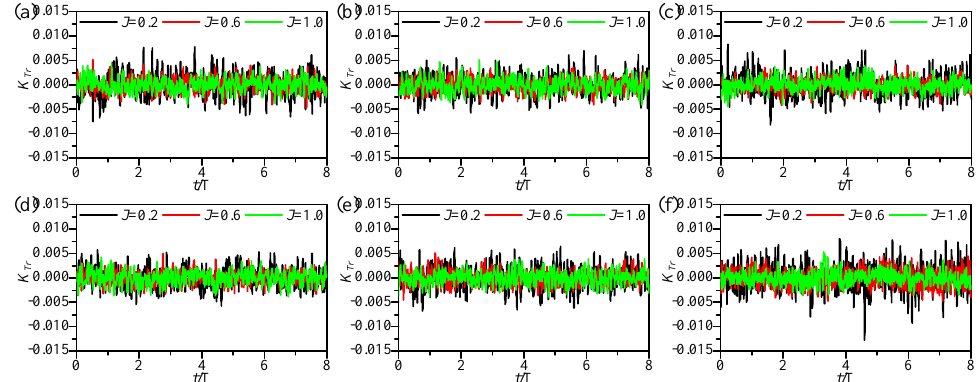
Figure 15. Time domain curves of fluctuation component of K Tr . (from ( a – f ) corresponding to PJP model ID 2 to 7).